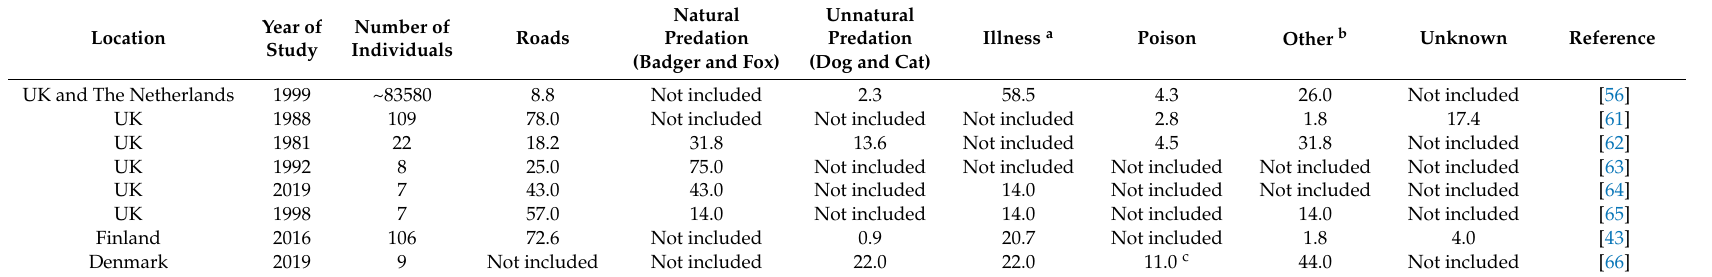
Table 2. Percentage of deaths by di ff erent sources for studied E. europaeus individuals in